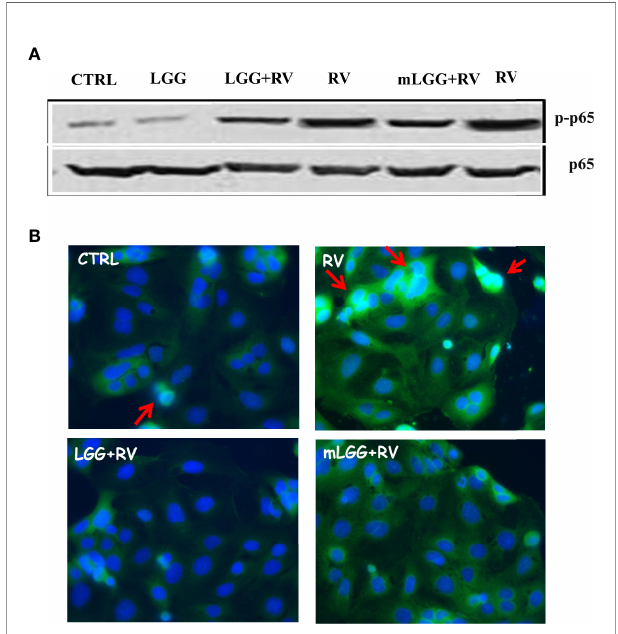
FIGURE 5 | Effect of LGG on RV-induced activation of NF-kB pathway in Caco-2 cells. (A) Activated NF-kB p65 subunit (upper panel) was evaluated in RV-infected Caco-2 cells with or without the addition of mLGG or LGG and compared to total p65 levels in a western blot experiment. (B) NF-kB p65 subunit was detected in RV-infected cells with or without the addition of mLGG or LGG with immuno fl uorescent method as described in “ Method ” section and nuclei were stained by Hoerst. Red arrows indicate the p65 nuclear localization. Data are representative of 3 separate